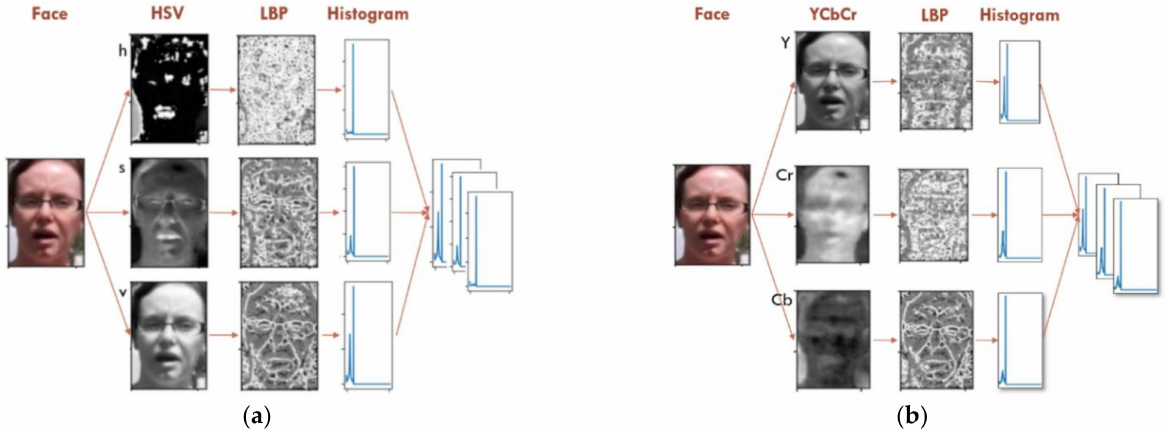
Figure 7. Texture analysis phases ( a ) using HSV color space and ( b ) using YC b C r color